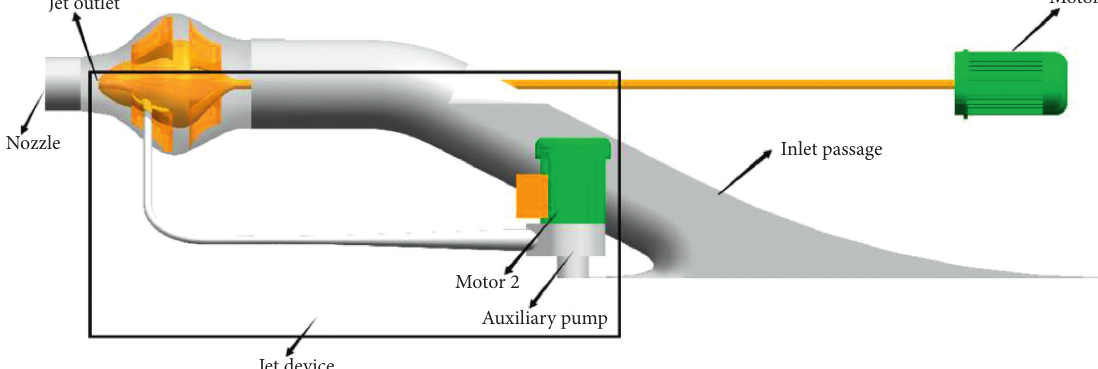
Figure 1: Schematic diagram of the geometric model of the water jet propulsion pump device with additional